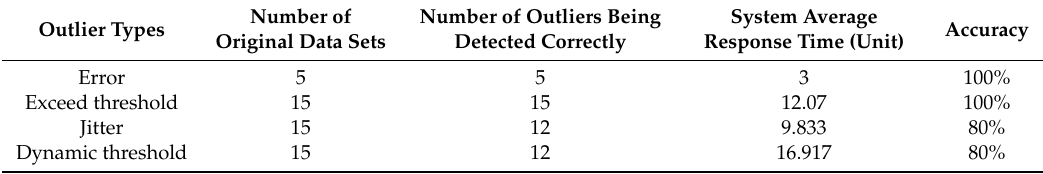
Table A4. Statistical outcomes of the experiment (sampling rate = 1 / 30 sec , network scale = 1000 nodes). Outlier